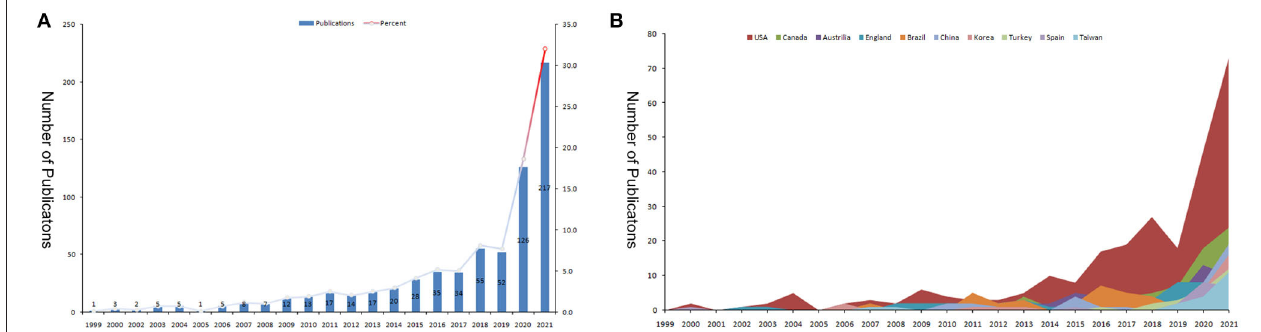
FIGURE 2 | The number of publications and total citations related to virtual simulation in nursing studies. (A) The number of papers published and total citations each year. (B) The top 10 countries/regions annual publications.